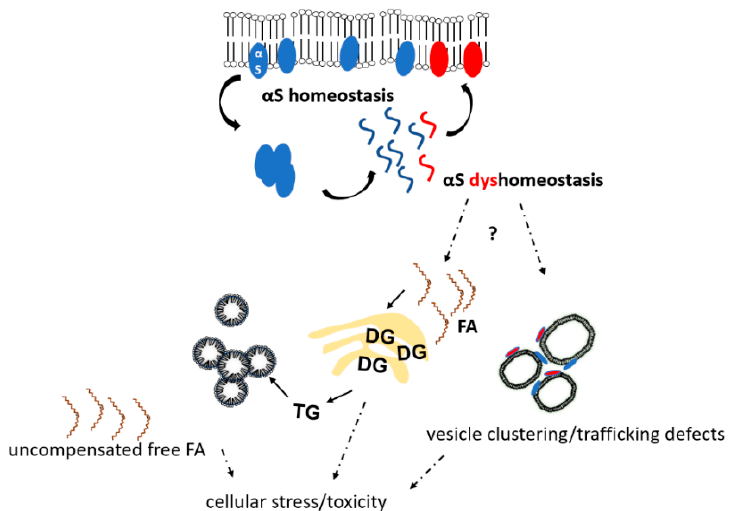
Figure 2. α S-induced lipid dyshomeostasis. α S homeostasis is characterized by balanced dynamic equilibria of soluble unfolded α S (blue wavy lines), membrane-associated α S monomers (blue ovals at membranes), and α S multimers (blue assembly in the cytosol). α S dyshomeostasis is initiated when α S monomers start to accumulate in the cytosol and/or at membranes (red wavy lines and ovals). By largely unknown mechanisms, α S dyshomeostasis triggers an imbalance in cellular lipid content, which comprises the accumulation of free FAs, DGs, TGs and oleic acid. α S excess at membranes (small red ovals, bottom right) causes vesicle clustering and/or trafficking defects. α S, α -synuclein; FA, fatty acid; DG, diacylglycerol; TG,